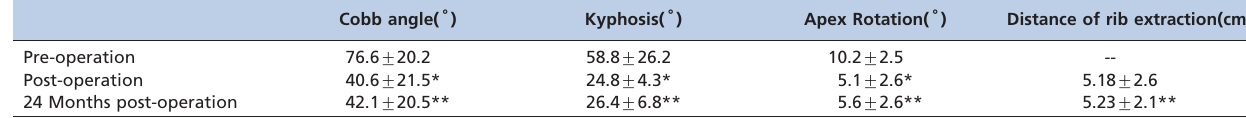
Table 2 - Comparison of pre-and post-operative radiology